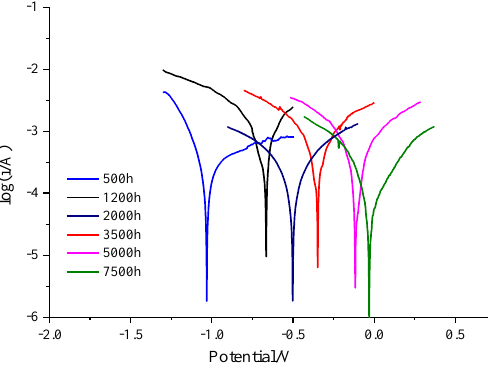
Figure 9. Polarization curves of inorganic zinc-rich coating after different salt-spray time. Table 2. Fitting data of polarization curves for inorganic zinc-rich coating after different salt-spray time.